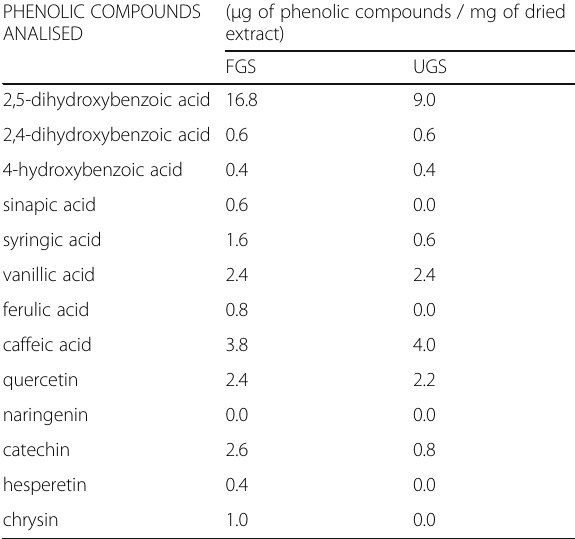
fermented (FGS) and unfermented (UGS) grape